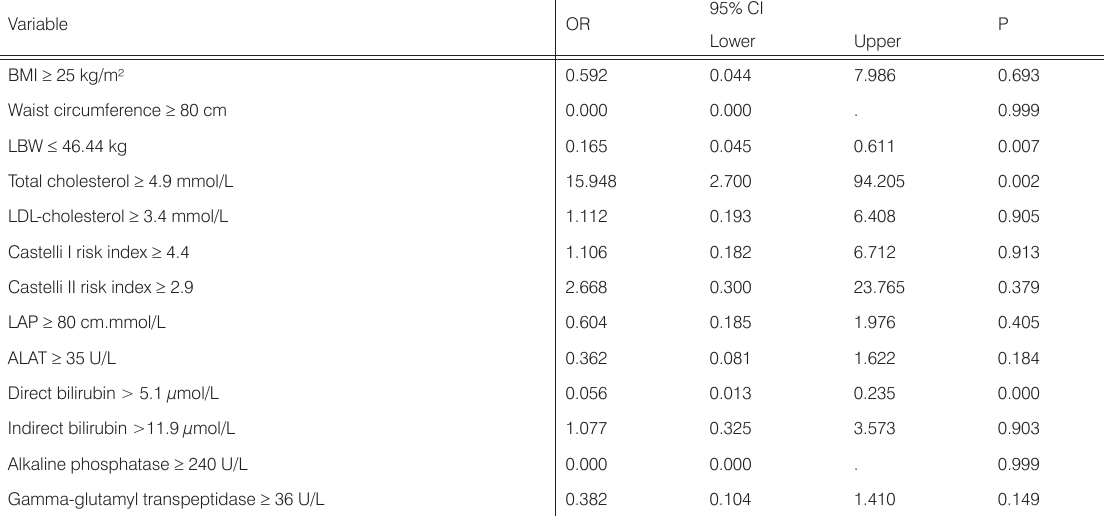
Table 3. The variables associated with cholelithiasis in a binary logistic regression model Variable